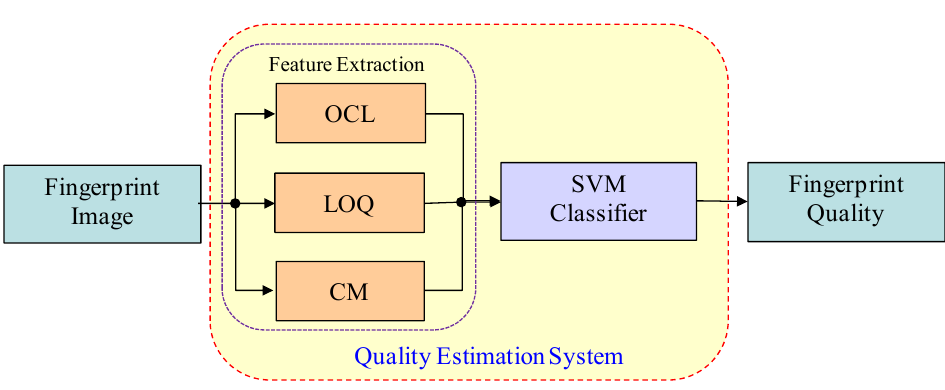
Figure 2. Fingerprint image quality estimation